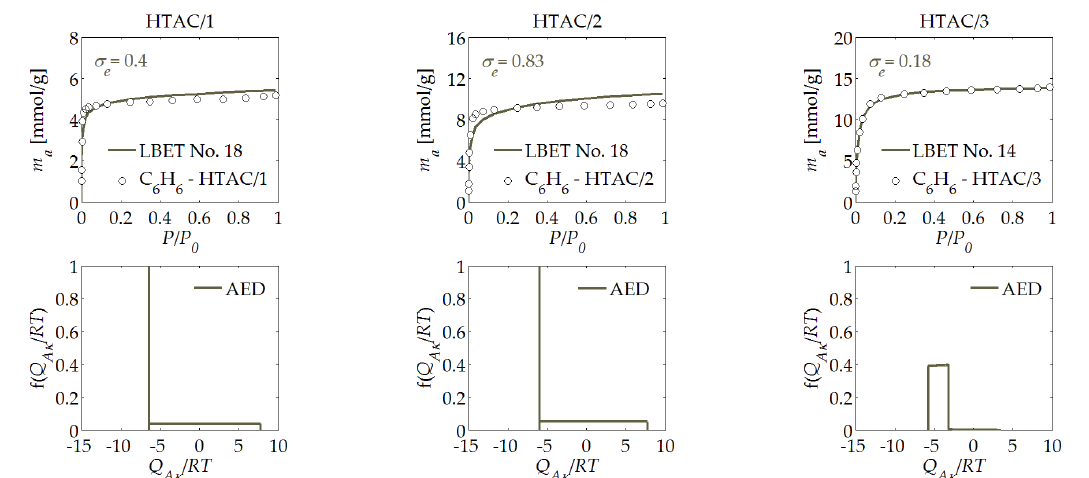
Figure 4. The same as Figure 1, but for the POAC/ R activated carbon derived from pistachio nut shells.